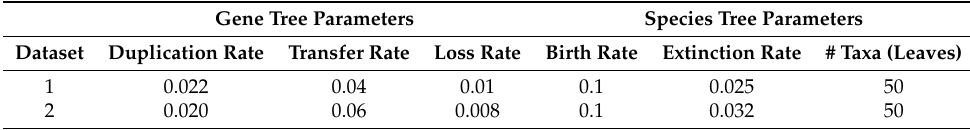
Table 1. Parameter settings used to generate simulated datasets using Zombi. Gene Tree